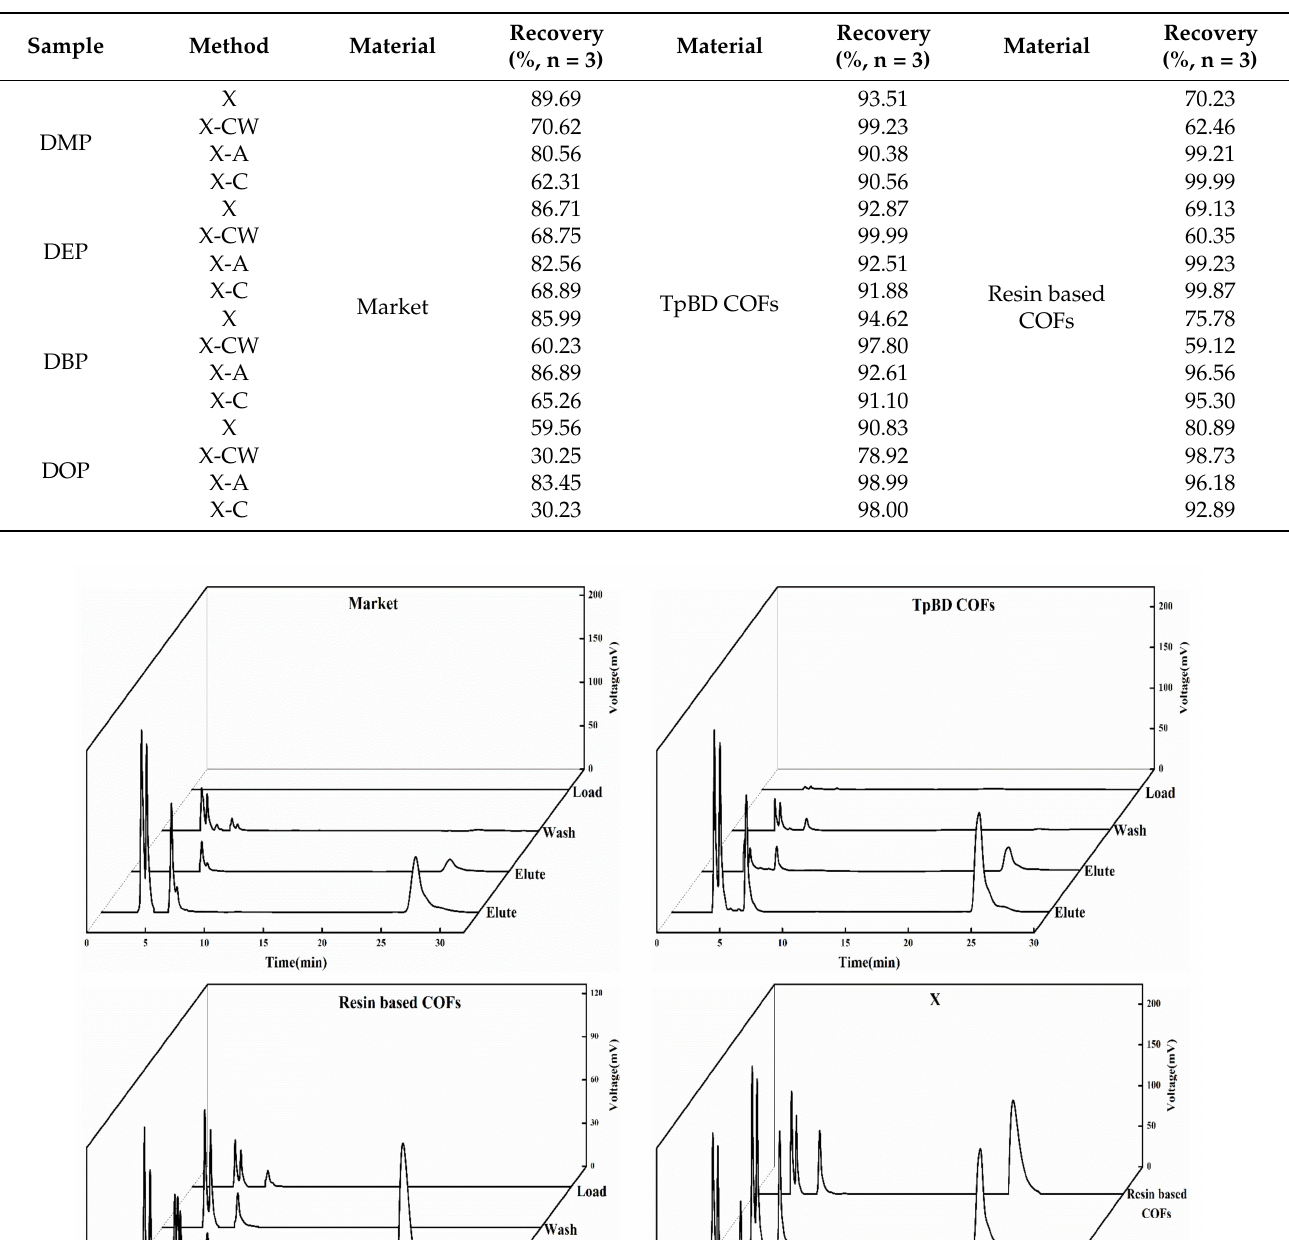
Table 6. Recovery of different SPE schemes.